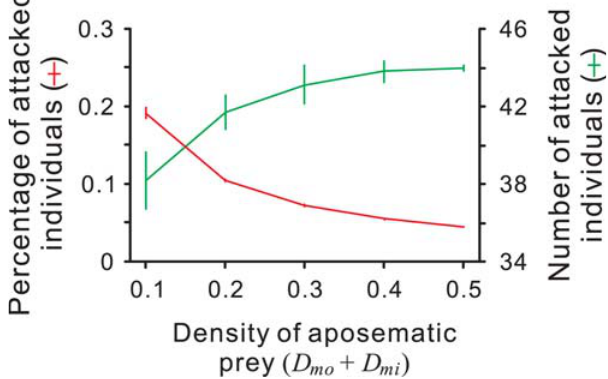
Figure 4. The result of a reciprocal frequency simulation. Each point and error bar denote the mean predation risk and its standard deviation of the replications. The abundance of the Mimic (p) relative to that of the Model is varied but the total number of prey is kept constant. X mo =0.2, X mi =0.8, T =0.8, a =0.5, w =0.02. Note that, in this reciprocal frequency treatment, increasing the ‘frequency’ of the Mimic raises the predation risk of the Model even in the condition in which the relationship would be no harm in Fig. 2.